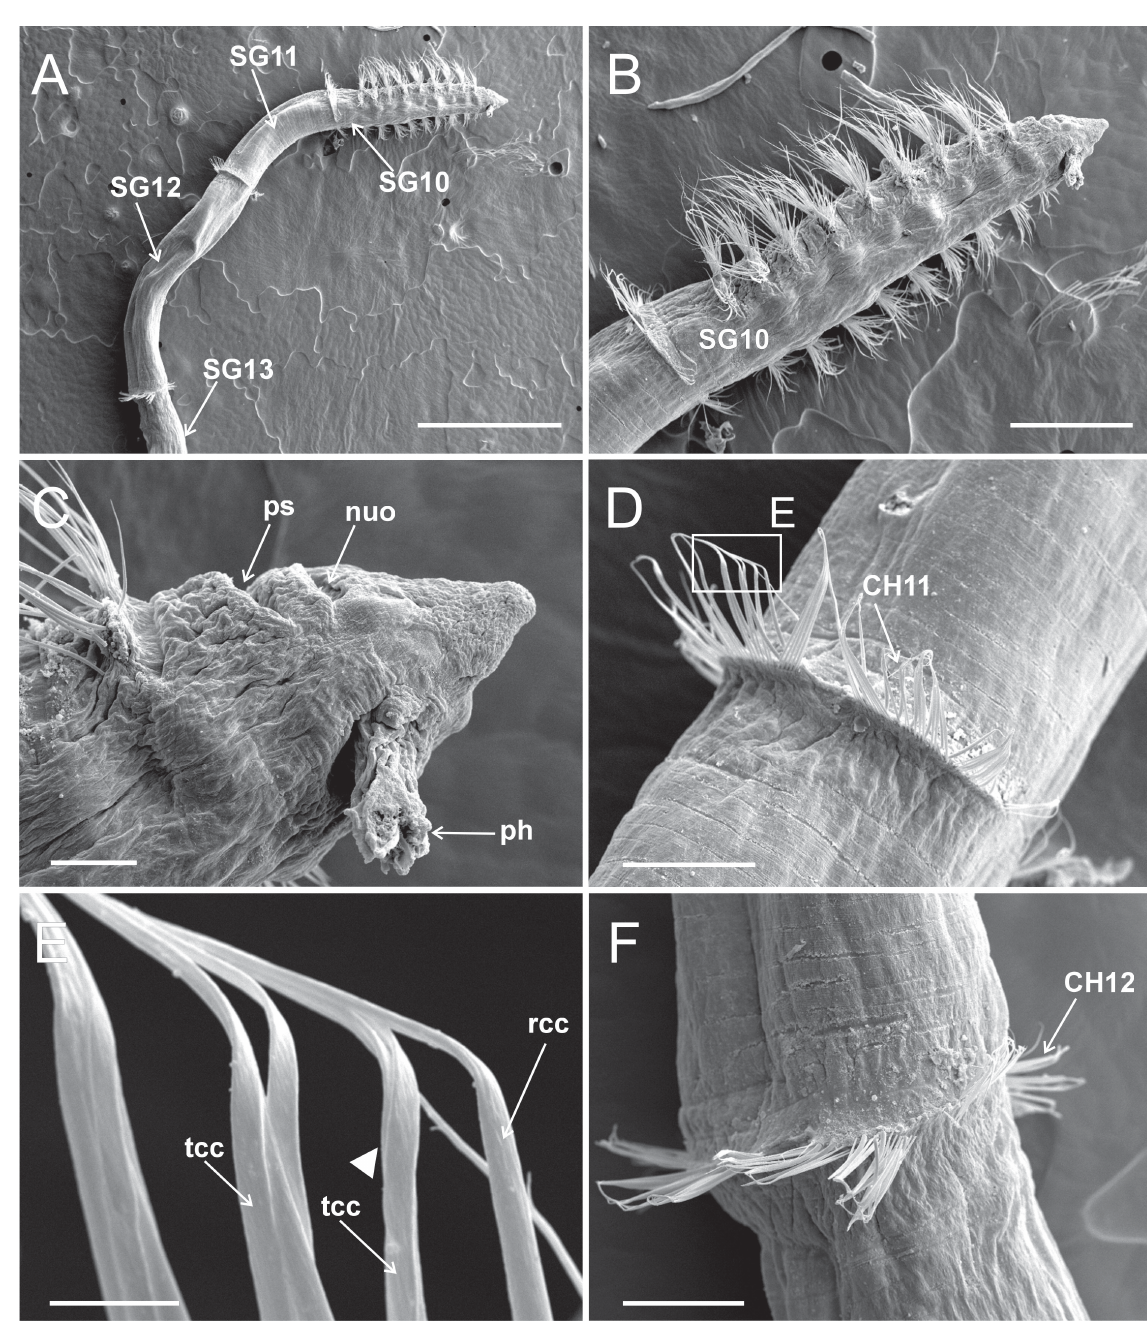
Fig. 8. Heterospio indica sp. nov., paratype (MNCN 16.01/17000), SEM micrographs. A . Specimen showing anterior short segments and first elongated segments, ventro-lateral view (scale bar = 1 mm). B . Detail of anterior region, ventro-lateral view (scale bar = 300 m m). C . Detail of anterior end, ventral view (scale bar = 50 m m). D . Flange-like chaetae of CH11, framed area showing chaetal detail in (E) (scale bar = 100 m m). E . Detail of distal end of both types of capillary chaetae, arrowheads showing start of opening end in thin capillary chaetae (scale bar = 10 m m). F . Flange-like chaetae of CH12 (scale bar = 100 m m). Abbreviations: CH = chaetiger; nuo = nuchal organ; ph = pharynx; ps = palp scar; rcc = robust capillary chaetae; SG = segment; tcc = thin capillary